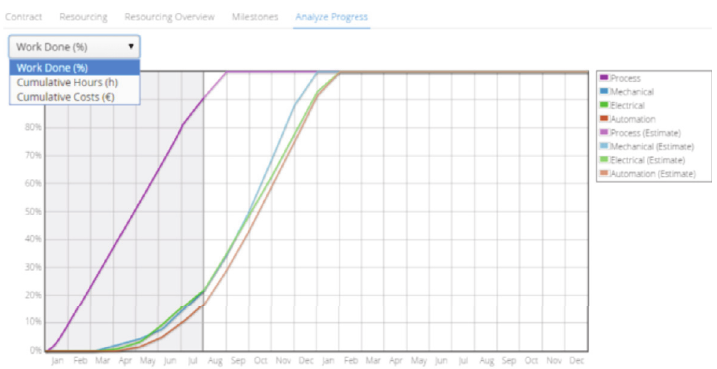
Figure 13: Analyze progress